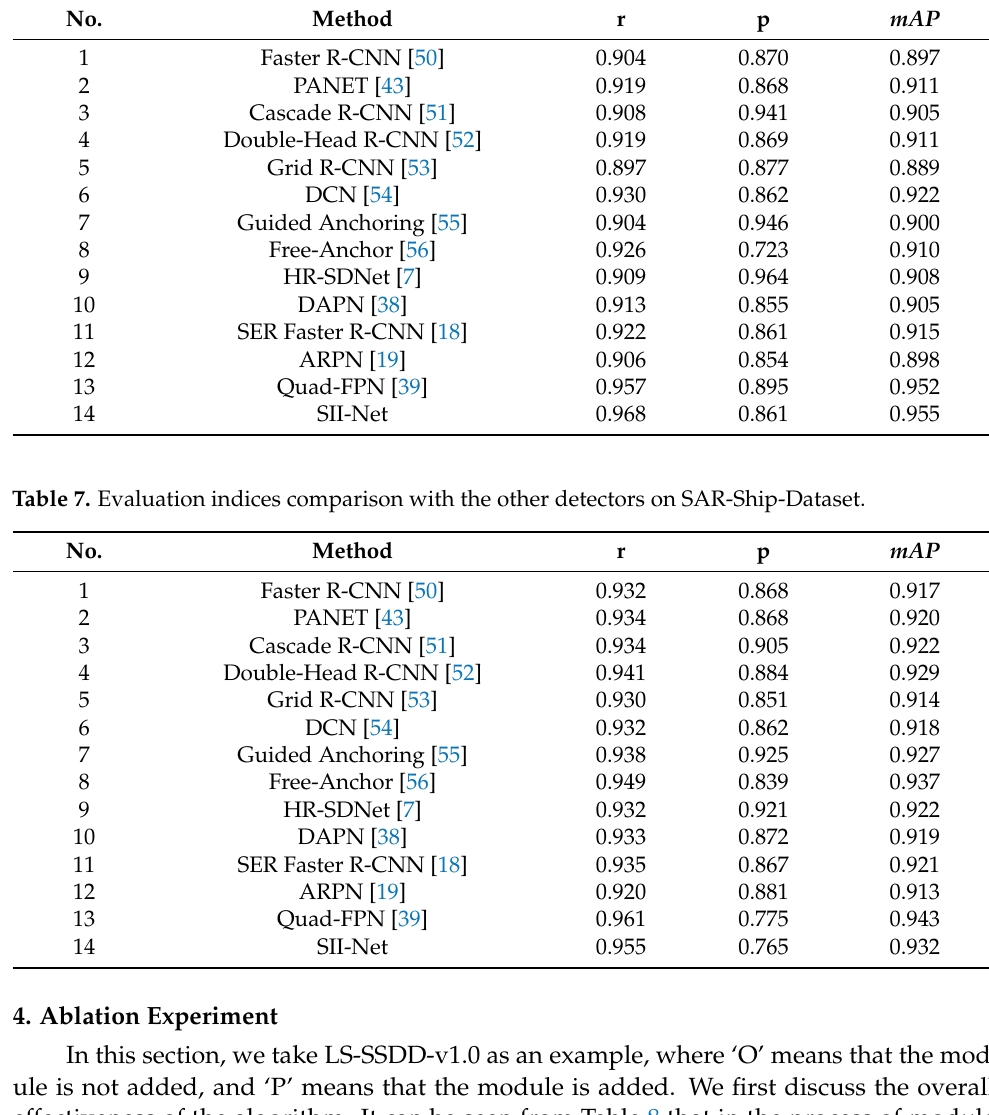
Table 6. Evaluation indices comparison with the other detectors on SSDD.